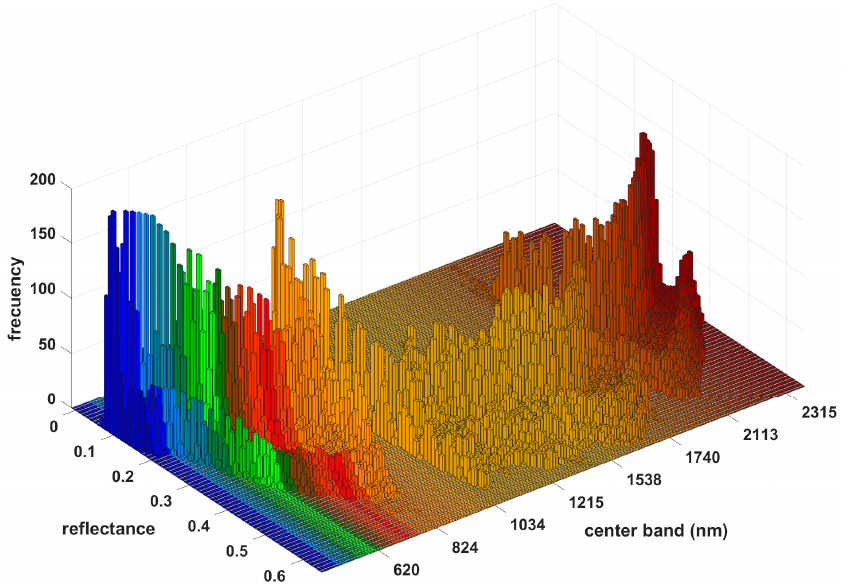
Figure 4. Reflectance histograms per band for a block with 22% of cloud cover (A 1 ), based on the image t 8 .